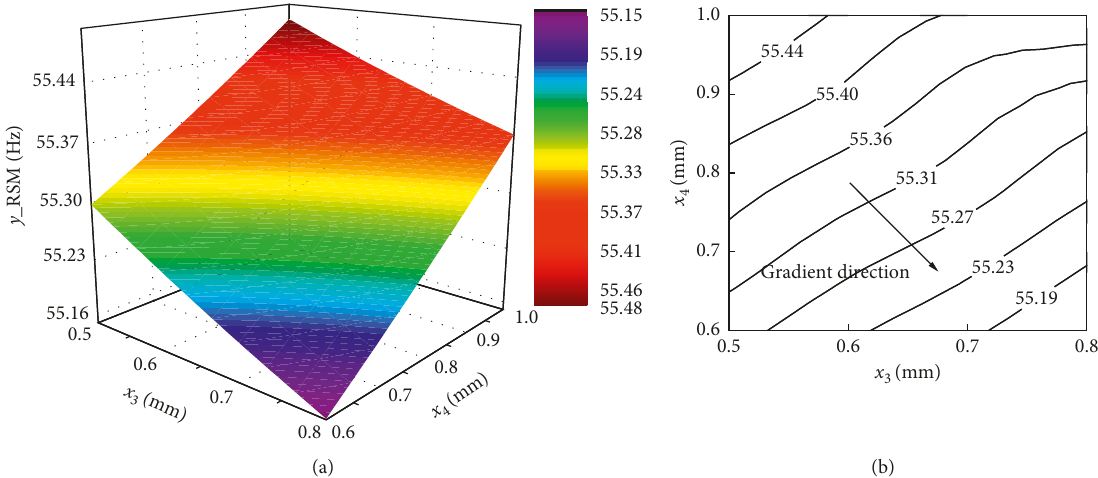
Figure 5: Modal frequency responses with respect to design factors x of modal